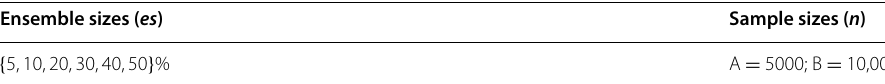
Table 2 Parameter settings used in the experiments Ensemble sizes ( es